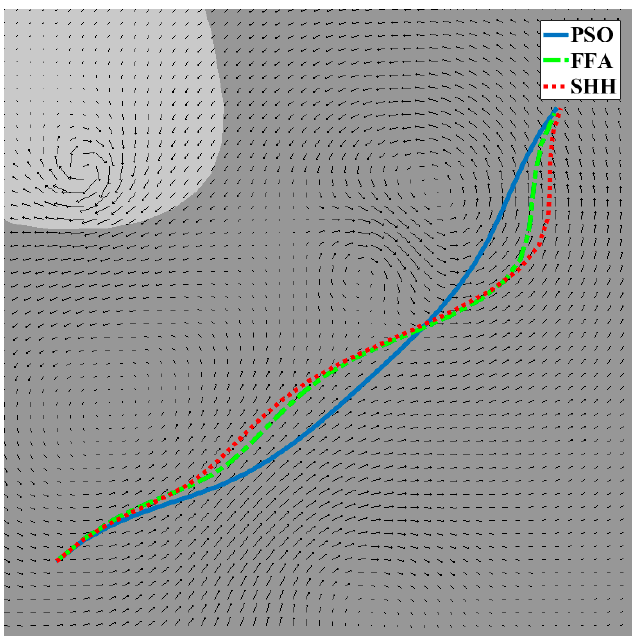
Figure 8. Comparison of the path planning results of PSO, FFA and SHH algorithms in scenario 1.